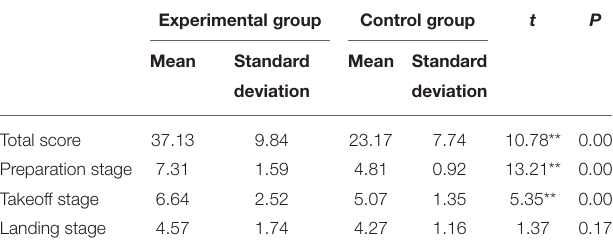
TABLE 2 | Total score comparison at different stages of jumping motor between the groups. Experimental